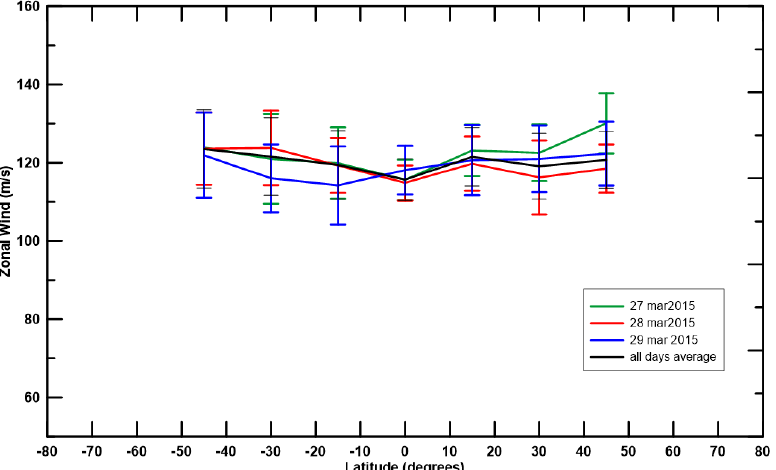
Figure 2. Latitudinal profile of zonal wind for each day of observation and the average values of the observation campaign (in black). For each day, we applied a weighted average of all the points at the same latitude, producing a daily latitudinal profile of the zonal